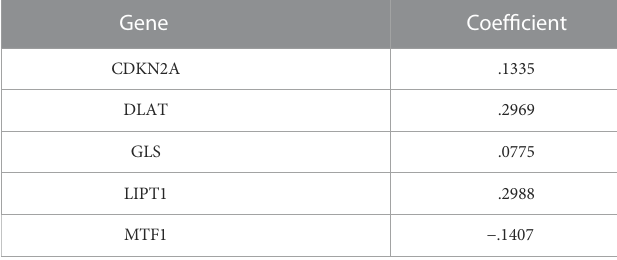
TABLE 1 Cuproptosis-related signature genes and coef fi cients.